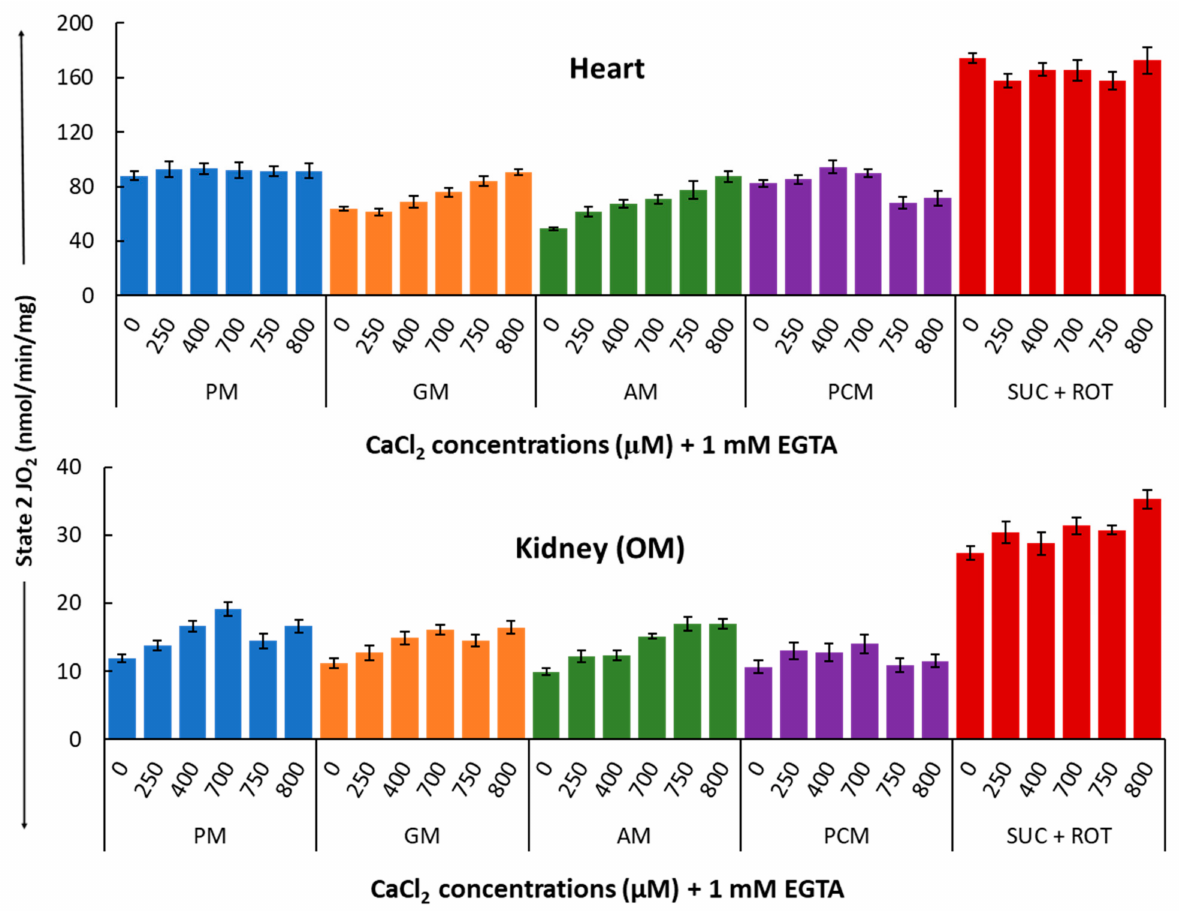
Figure 4. Summary of the different respiratory substrate-dependent effects of Ca 2+ on mitochondrial state 2 O 2 consumption rates (OCR; JO 2 ) for the heart (upper panel) and kidney OM (lower panel). The X-axis shows CaCl 2 added to the buffer in the presence of 1 mM Ca 2+ chelator EGTA. Each bar plot represents the mean value ± SEM ( n = 4–6) of state 2